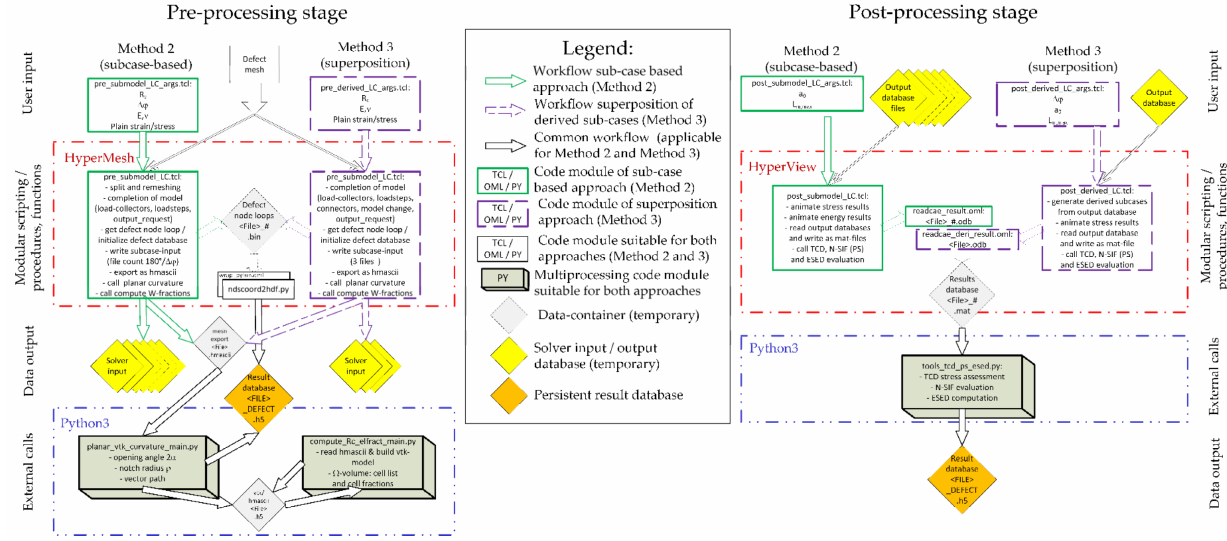
Figure 4. Structured workflow for local fatigue assessment of planar